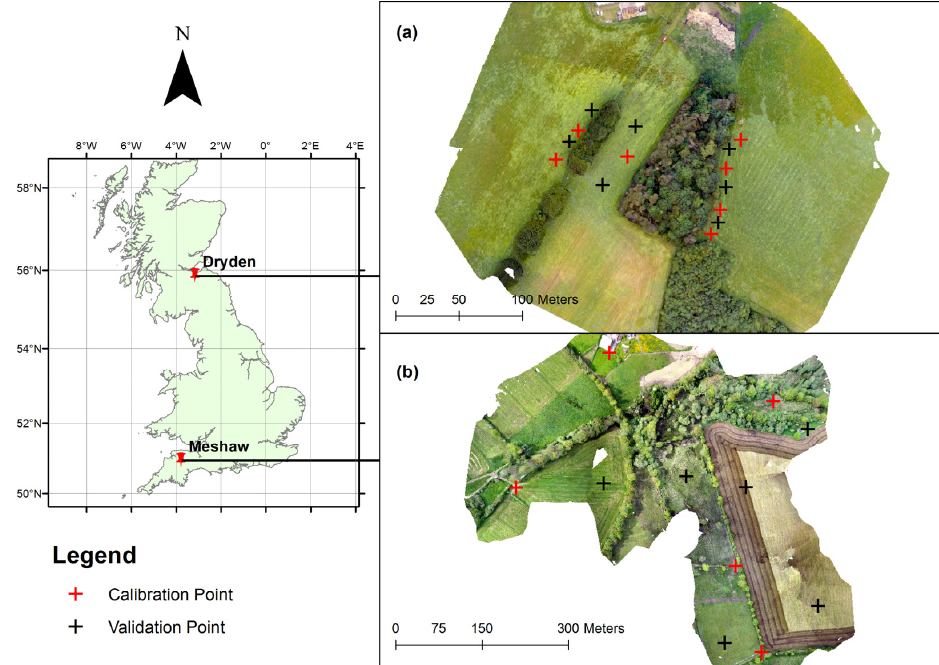
Figure 2. Test sites ( a ) Dryden and ( b ) Meshaw in the United Kingdom (left). For Meshaw calibration GCPs were obtained from a LiDAR DEM and at Dryden ground ‐ based GPS was used.